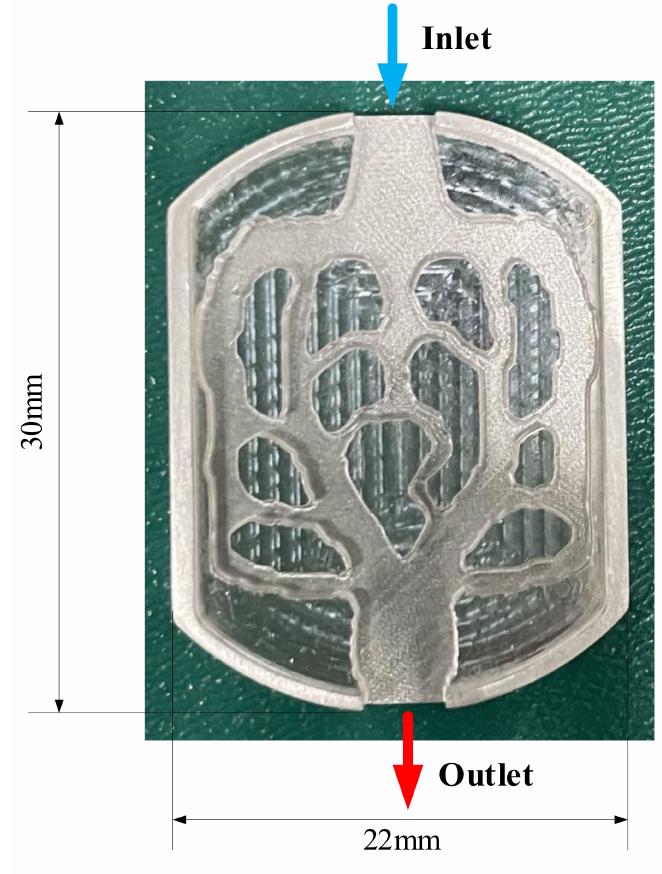
Figure 16. Experimental heat